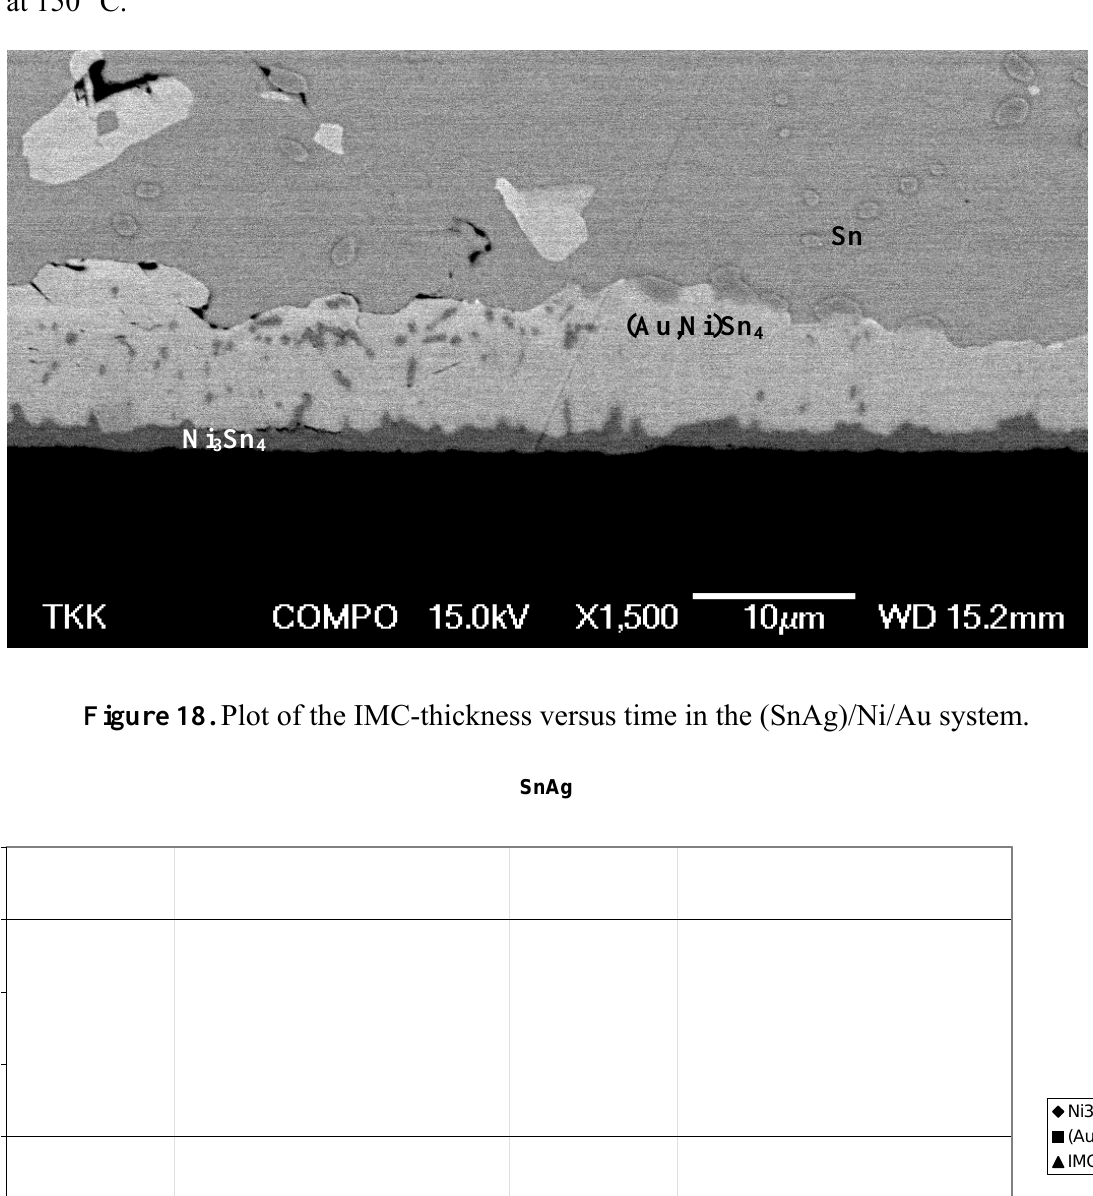
Figure 17. SEM micrograph from the (SnAg)/Ni/Au system after annealing for 250 hours at 150 °C.